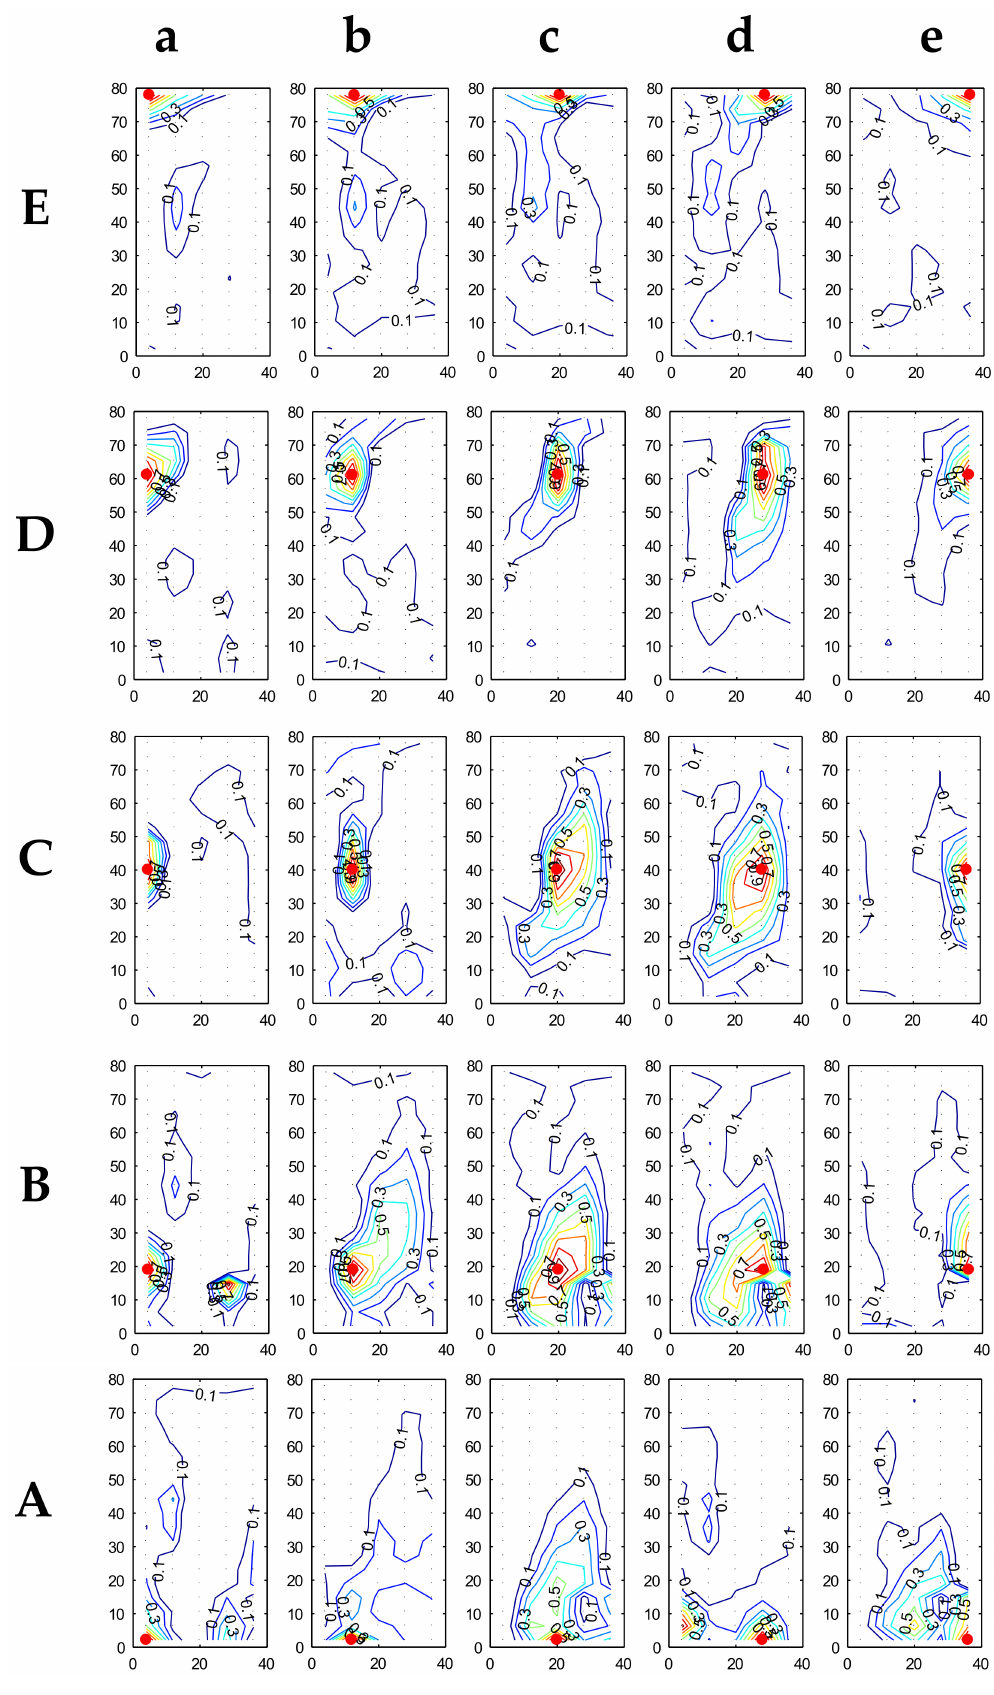
Figure 10. Correlation coefficient trend for RLF at 45 ◦ . Color bar as in Figure